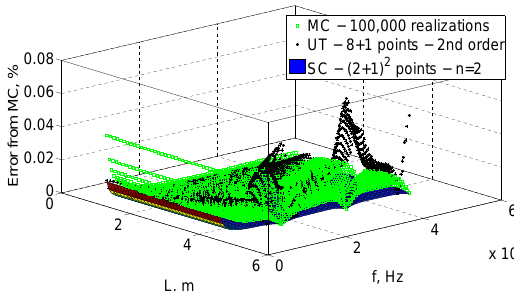
Figure 7: Mean(I) error from reference MC data ( 10 6 sim- ulations) for MC ( 10 5 realizations), UT8 and SC3.